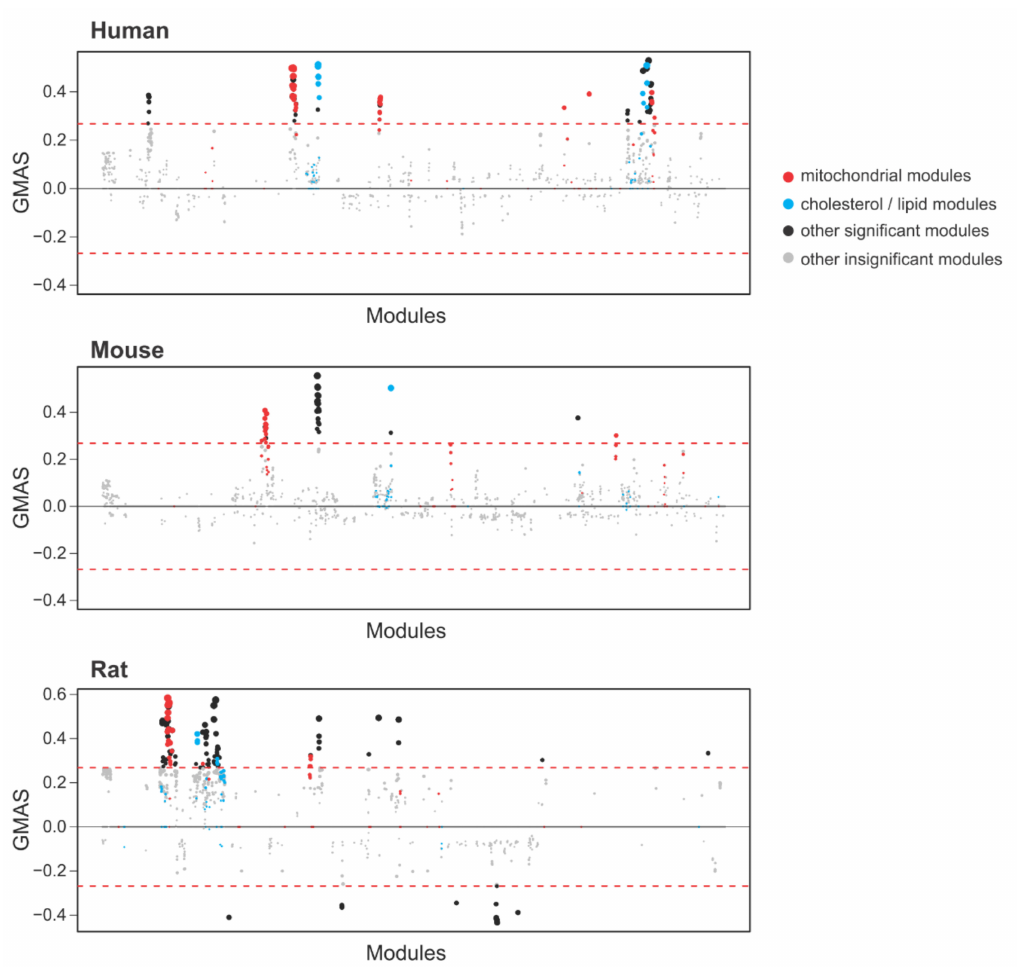
Figure 8. GeneBridge analysis identified the associations between TSTD1/Tstd1 and cholesterol metabolism as well as mitochondrial function. GeneBridge analysis was performed using liver datasets in human, mouse and rat. Pathway modules were arranged horizontally according to the similarity between modules, and the gene-module association scores (GMAS) were shown in the y-axis. The significance thresholds are indicated by the red dashed line. Modules related to mitochondrial function are indicated by red dots, while those related to cholesterol or lipid metabolism are indicated by blue